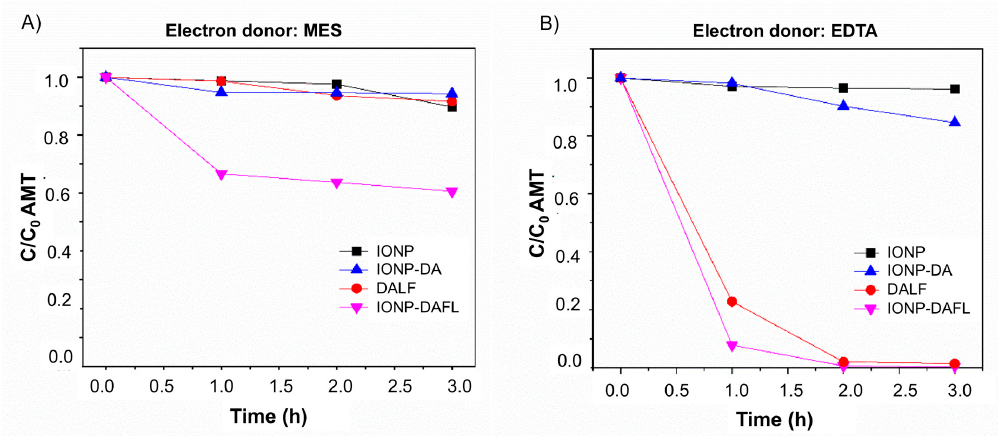
Figure 5. The relative concentration of remaining AMT in solution (C/C 0 ) measured using UV-Vis absorption spectroscopy ( λ max = 520 nm) after irradiation with 450 nm blue light for 3 h in the presence of IONP-DAFL, DAFL, IONP, or IONP-DA in (A) MES (0.1 M) and in (B) EDTA (0.1 M) under an Ar